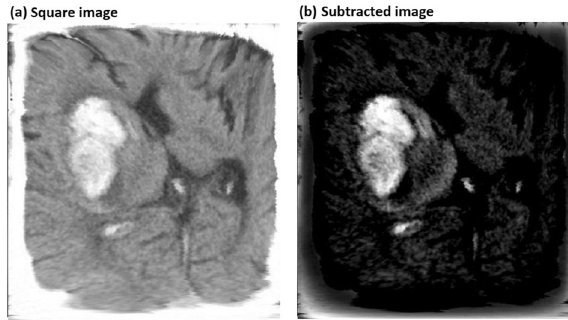
Figure 2. Example of CT image processing for preparing image data. ( a ) Square image expanded to fit in a square. ( b ) Subtracted image to eliminate the skull image and other images not related to ICH.